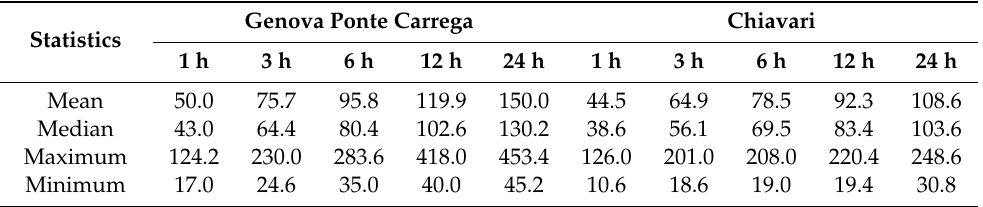
Table 5. Descriptive statistics of hourly rainfall at Genoa Ponte Carrega (1939–2019) and Chiavari (1932–2019) rain gauges.